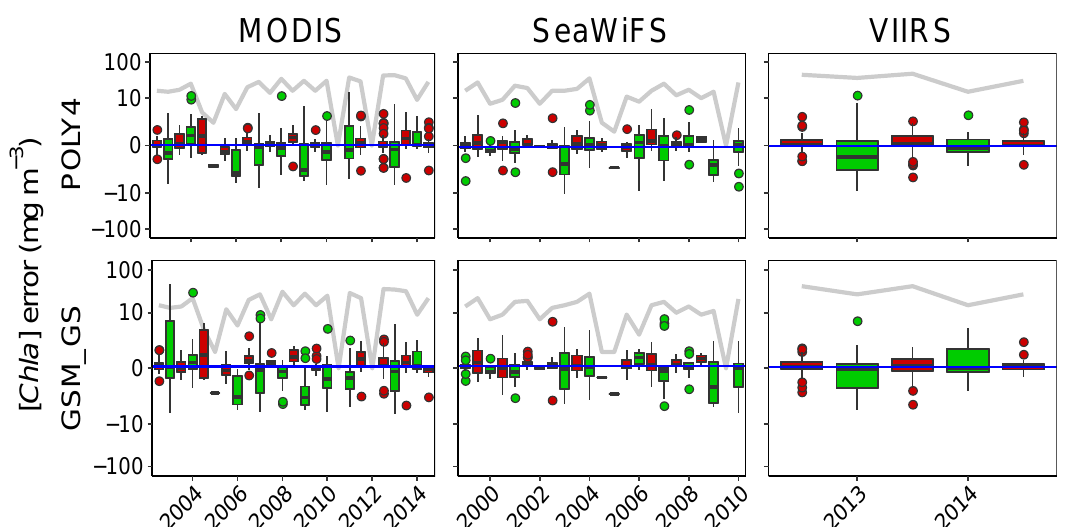
Figure 6. Model residuals across the full-time series for the POLY4 and GSM_GS algorithms in the NWA for MODIS, SeaWiFS and VIIRS. Blue lines represent µ error , and the grey lines indicate the number of valid retrievals. Green boxes represent the first half of the year (January to June) and red boxes represent the second half (July to December). Note the axis is asinh-transformed.